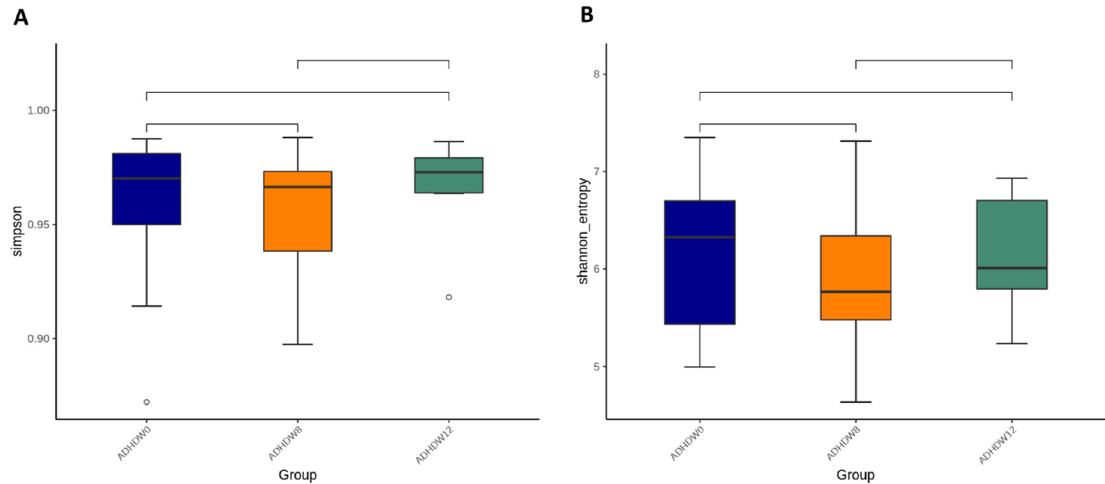
Figure 5. The Simpson index ( A ) and Shannon index ( B ) among ADHD patients at baseline, week 8, and week 12.